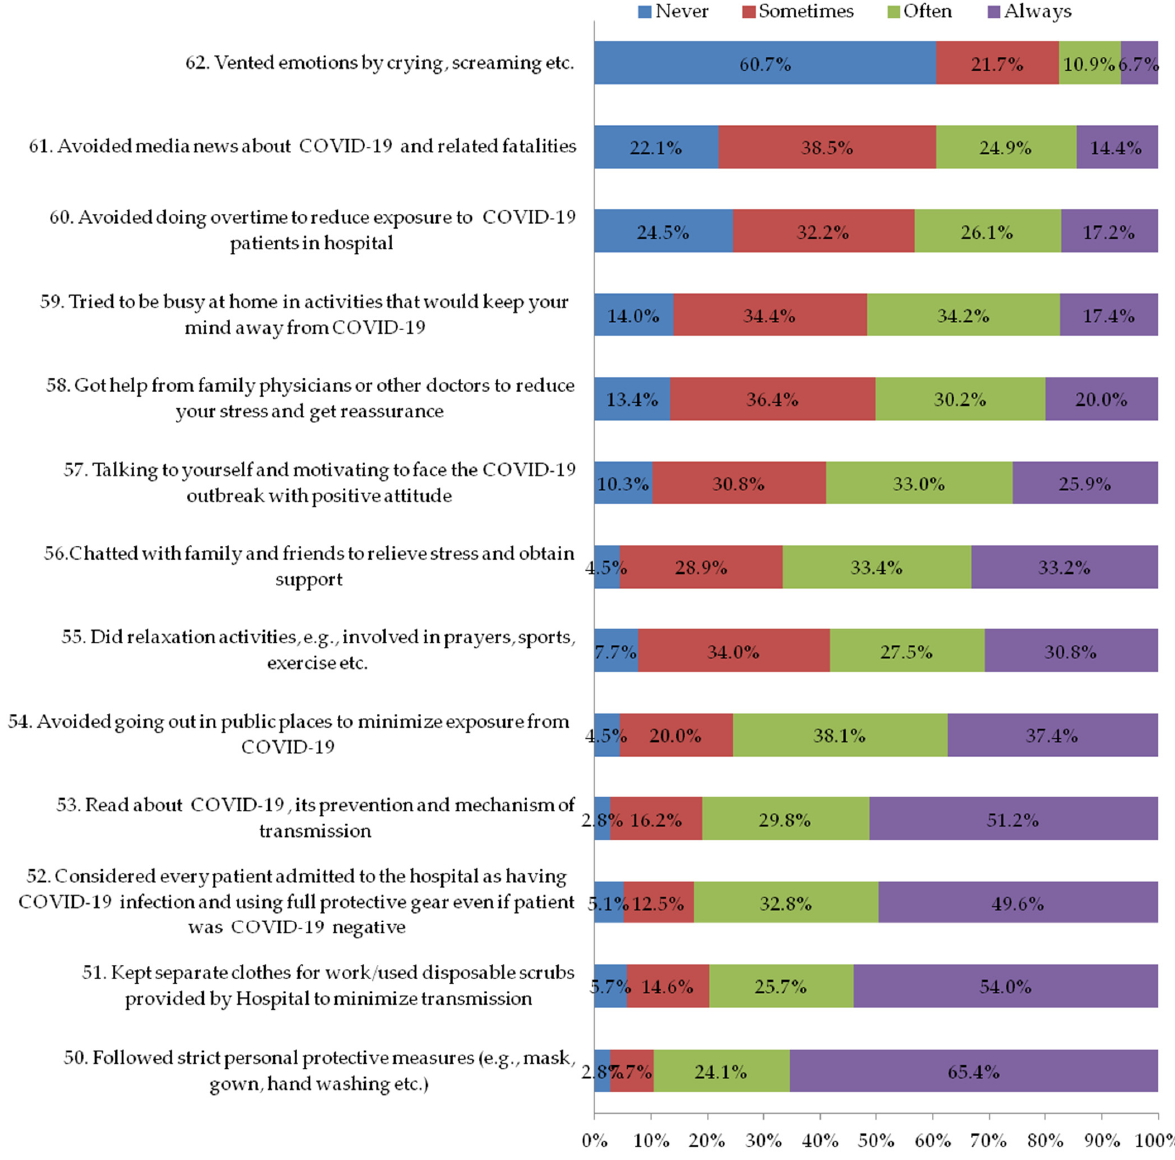
Figure 4. Personal coping strategies staff could have used during COVID-19 outbreak.